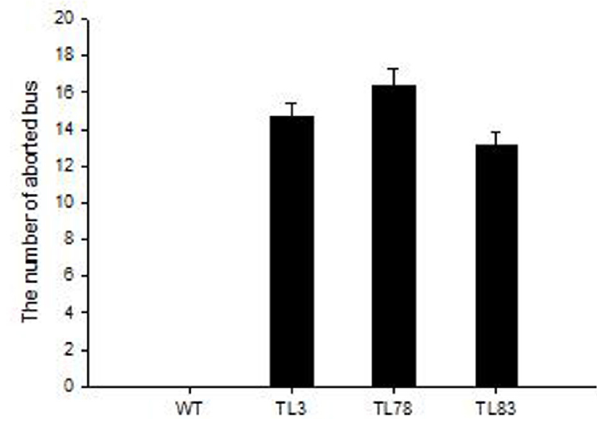
Figure 7. The number of aborted flower buds on the primary inflorescence of Arabidopsis plants subjected to heat stress. WT, Col-0 of Arabidopsis thaliana ; TL3, TL78, TL83 are homozygous transgenic lines. Error bars represent the mean ± SD of three independent biological